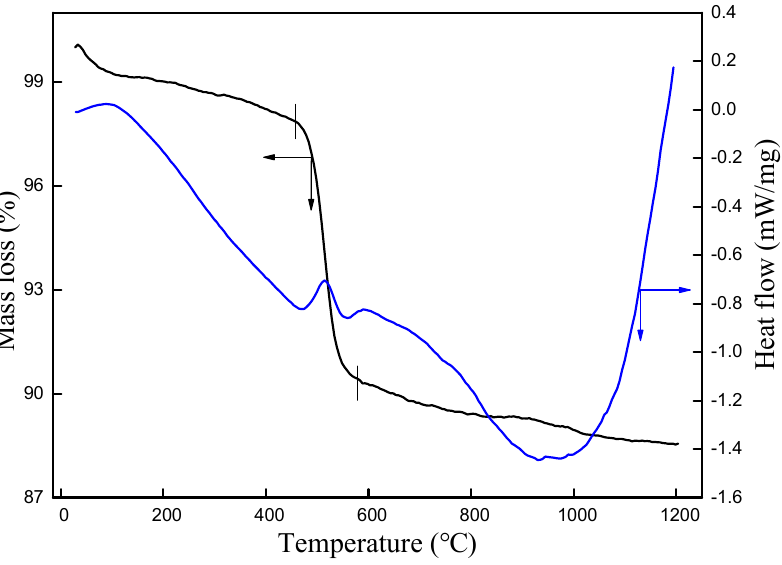
Figure 4. Thermogravimetric (TG) and differential scanning calorimetry (DSC) plots of bauxite sample.